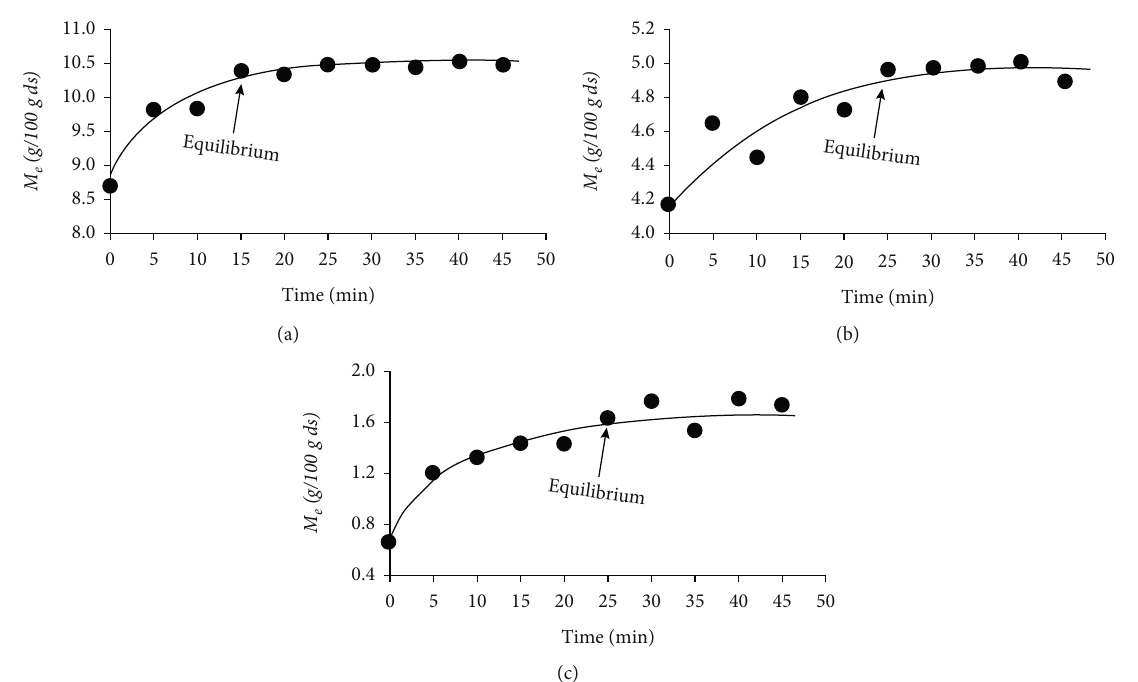
Figure 3: Adsorption kinetics of the dried samples at 15% relative humidity at 30 ° C ((a) cellulose, (b) lignin, and (c)